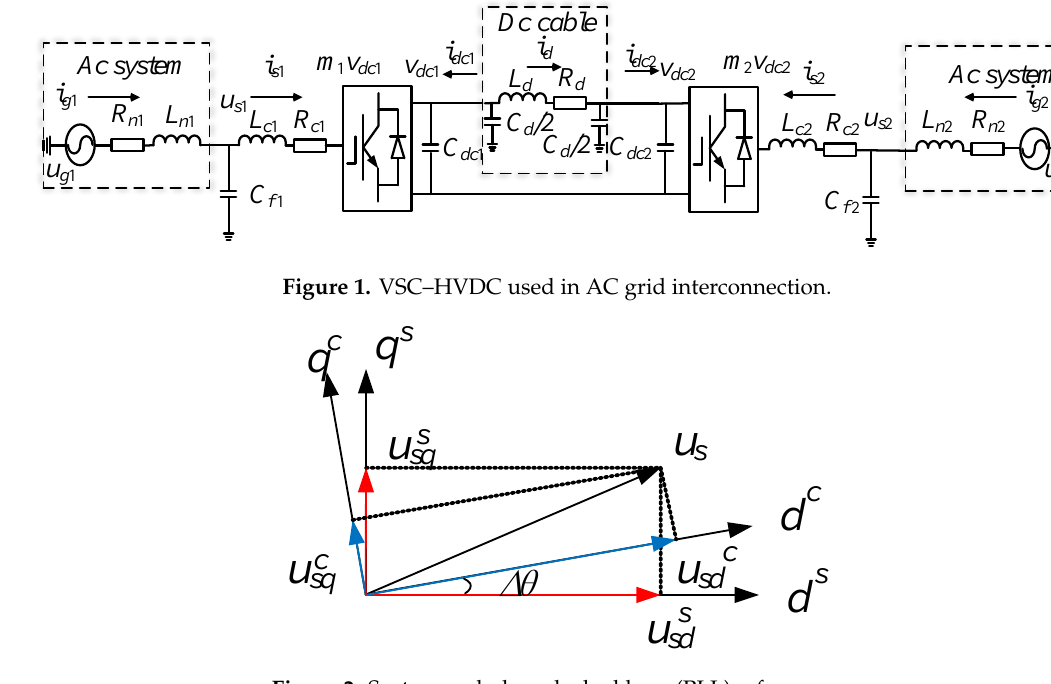
Figure 2. System and phase-locked loop (PLL) references.